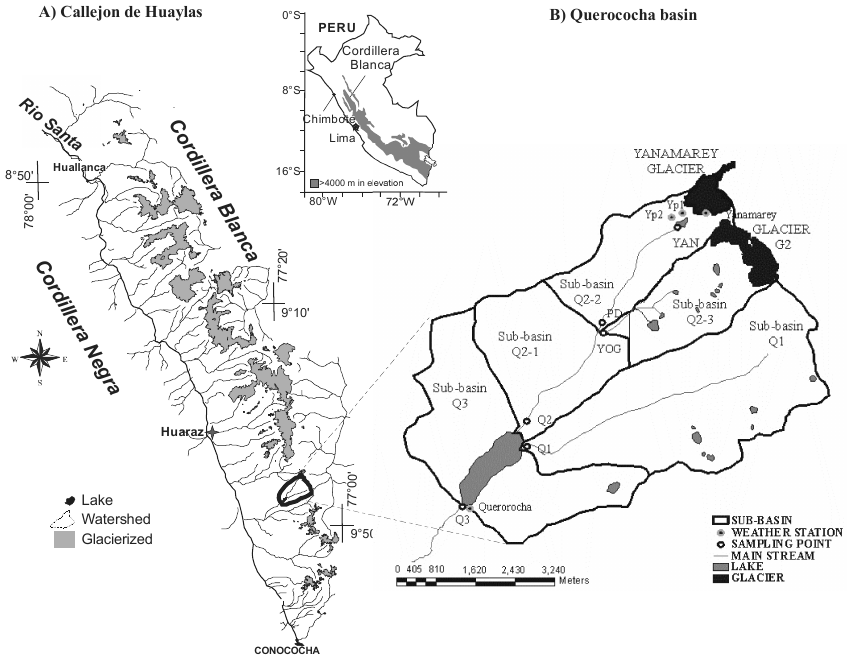
Fig. 1. Map of study area. (A) Callejon de Huaylas map; (B) Querococha Basin map. Sub-basins are delineated for using the HBCM.